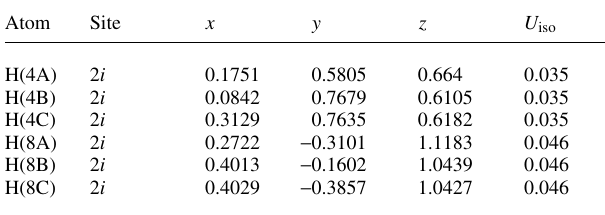
Table 2. Atomic coordinates and displacement parameters (in Å 2 ) .